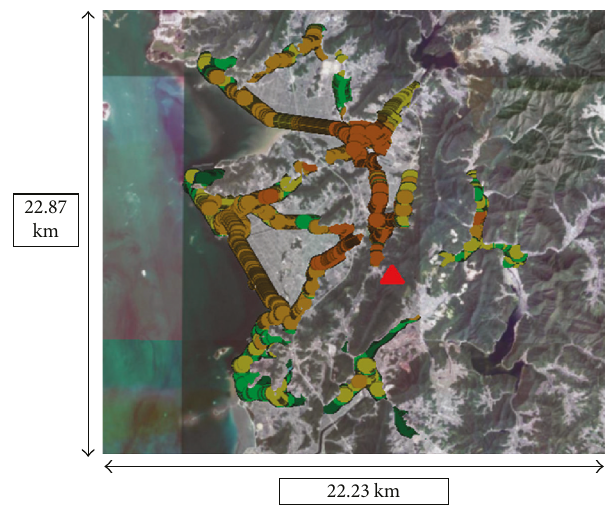
Figure 10: Measurements in Mt.